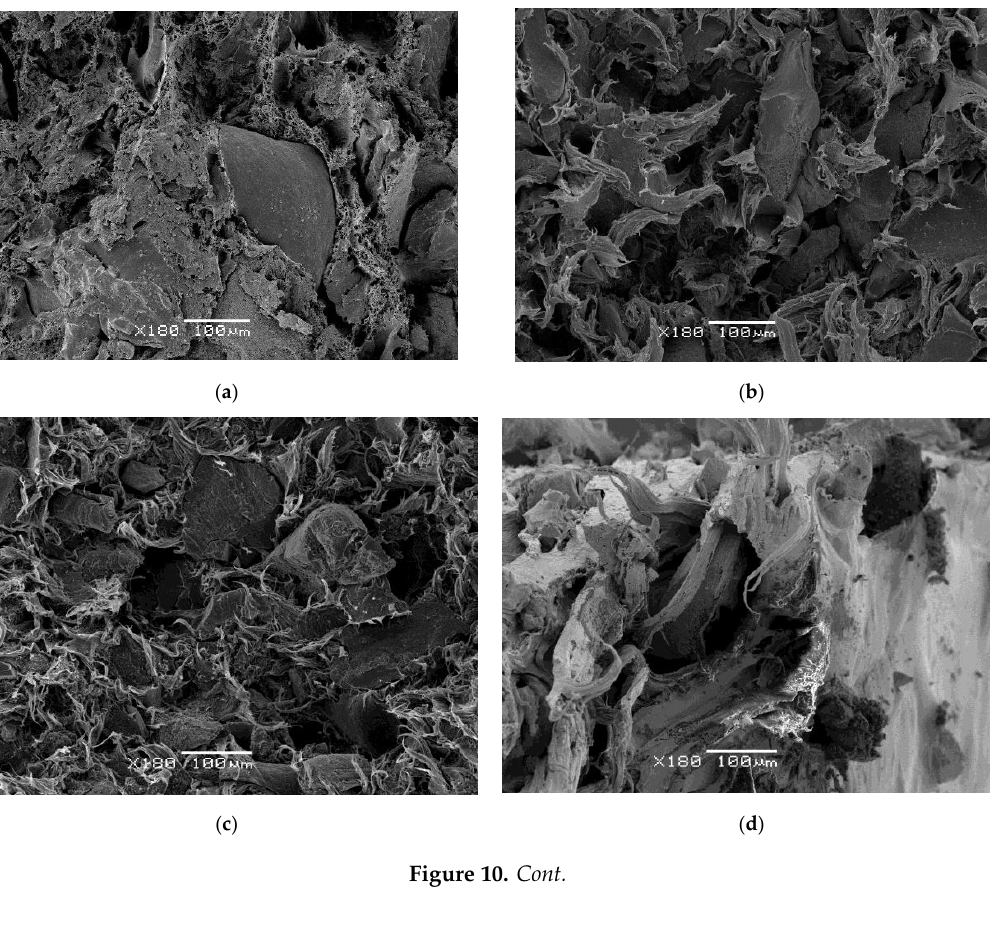
Figure 9. Thermal analysis of end of life tire polymeric blends: ( a ) degree of crystallinity (%) for crystalline polymers and ( b ) glass transition temperature (°C) for amorphous